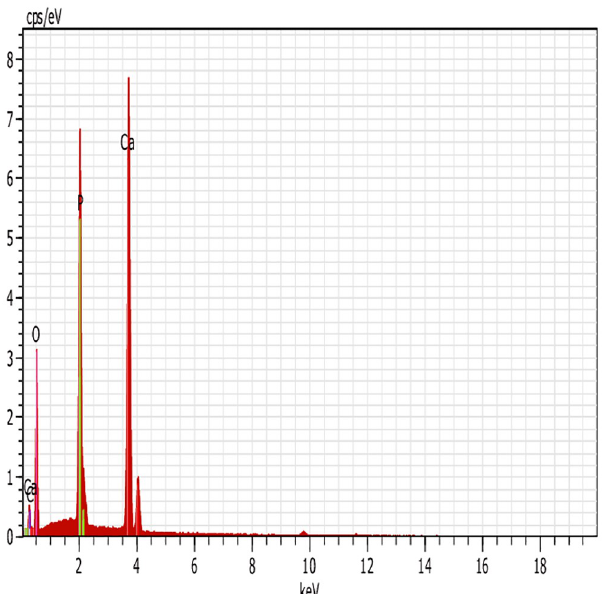
Fig 20. EDX result for HAp powder at optimal conditions (time = 10 h, pH = 10, temperature = 130˚C).